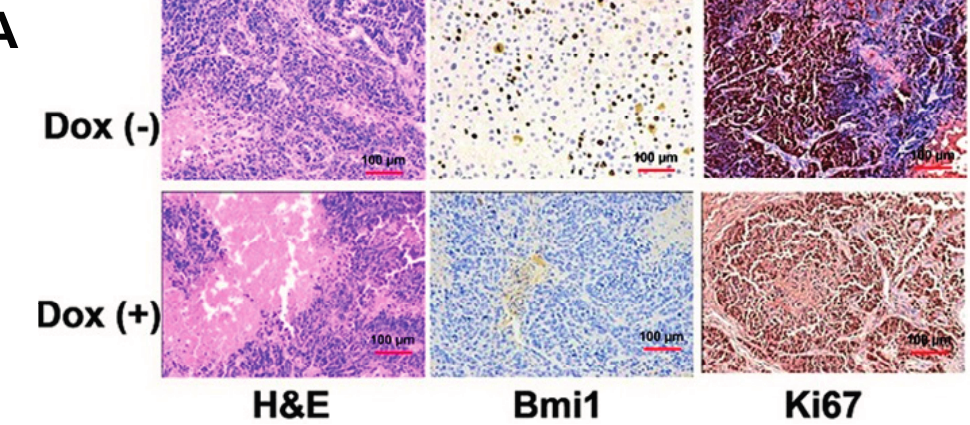
Figure 6. Characterization and apoptosis detection of tumor tissues. ( A ) Immunohistology of tumor tissues in nude mice. Tumor tissues were collected from the moribund mice at the end of the experiment; and ( B ) TUNEL assay in the tumors treated with doxycycline. The percentage of TUNEL-positive cells was determined by counting TUNEL-positive cells and total cells in the same fields ( n = 3). Data are expressed as the mean ± SD. * p <